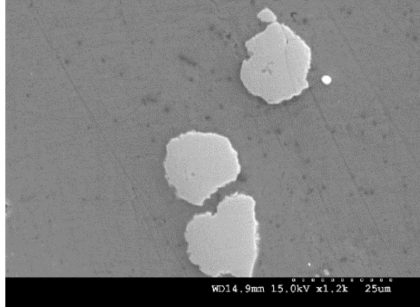
Figure 10. Scanning electron micrograph shows clear interface in pure aluminum reinforced with